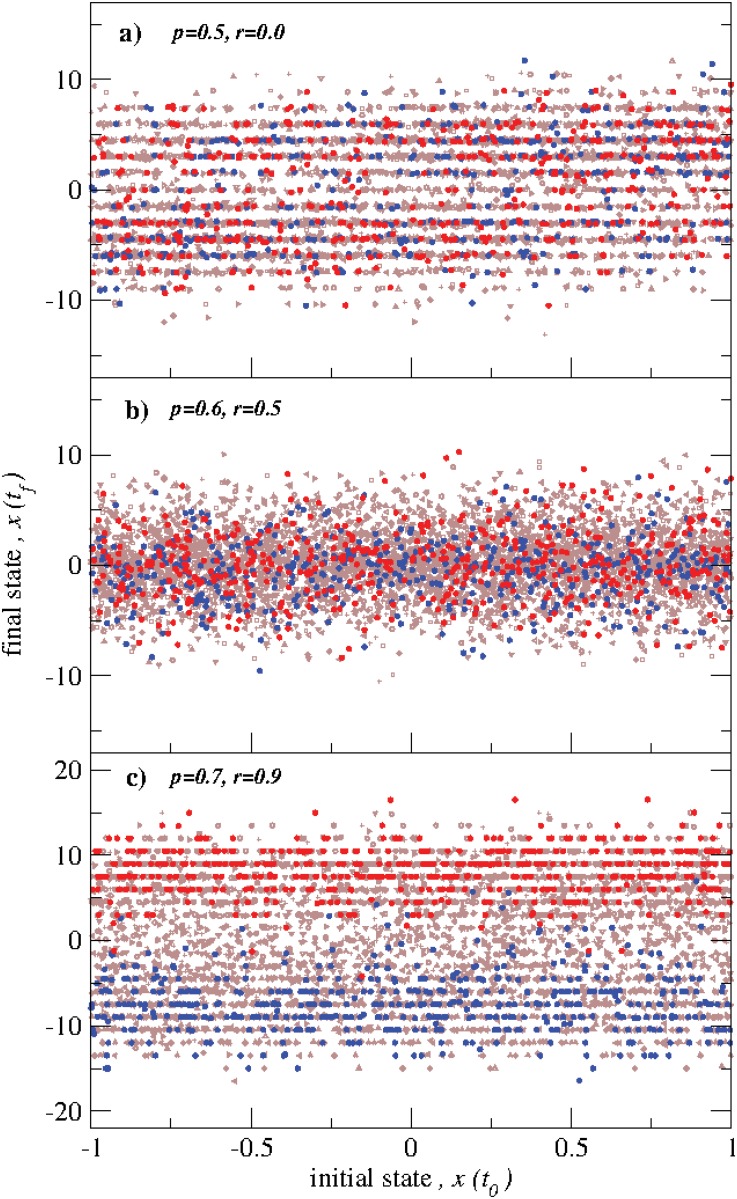
Scatter plots of states x(t
f) vs. x(t
i) for different values of p and r.Here we show the results of 10 independent evolutions, and we have colored two of them in red and blue, in order to show a single realization. (a) For the case p = 0.5 and the cooperativity ratio r = 0.0 (i.e. when all actors are competitors), the final states are independent of the initial ones and distributed along strips. (b) As in (a) but for p = 0.6 and r = 0.5 (i.e. the numbers of cooperators and cooperators are equal), for this case the final values tend to be more confined and the strips are not well defined. (c) As in (a) but for p = 0.7 and r = 0.9, now the strips are present and it is noteworthy that most of the actors tend to have final values either positive or negative.